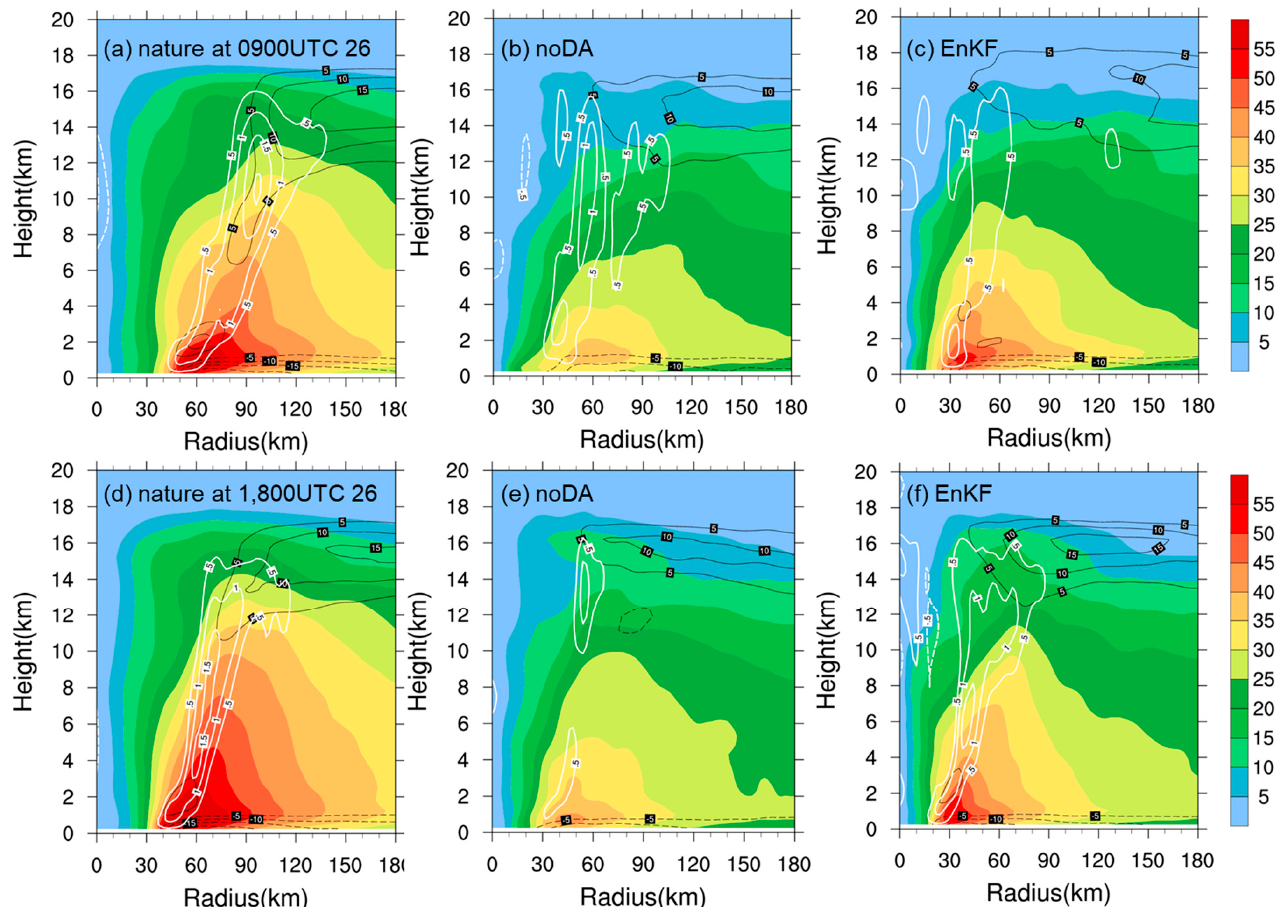
Figure 5. Azimuthal averaged tangential wind speed (shaded) and radial wind of TC Molave in nature run (left column), noDA (middle column), and EnKF (right column) at 09:00 UTC ( a – c ) and 18:00 UTC ( d – f ) on 26 October 2020.